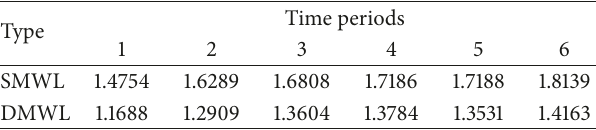
Table3:EvolutionofmeanwordlengthinwrittenChinesenarrative texts across 2000 years (adapted from